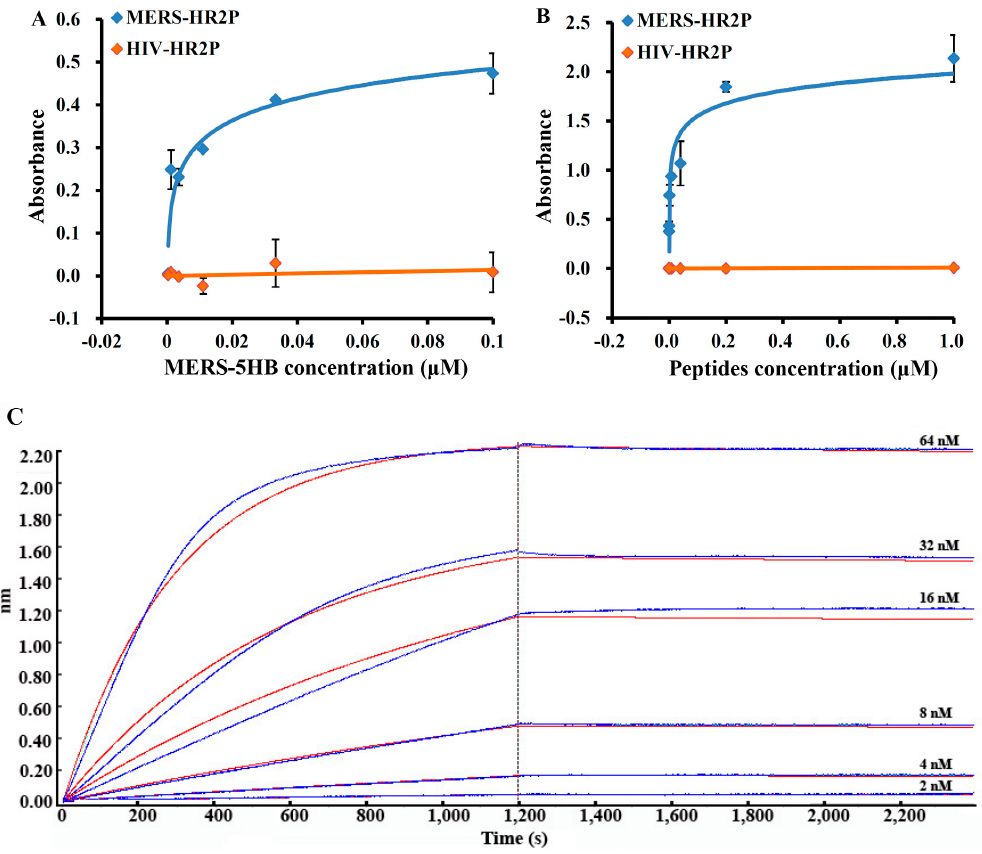
Figure 2. Interaction of MERS-5HB with MERS-HR2P derived from the HR2 region. MERS-HR2P was immobilized on the plate, with MERS-5HB binding detected ( A ). In the reverse, MERS-5HB was coated on the plate with MERS-HR2P for detection ( B ). HIV-HR2P was used as control. All